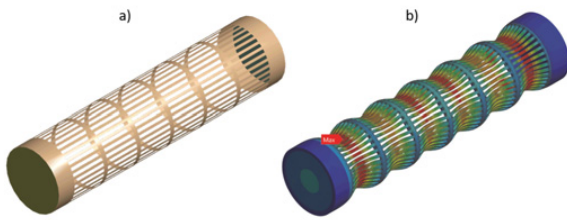
Figure 6. (a) Design of the decay chamber and vacuum window support structure. (b) Simulated with ANSYS software [36] deformation caused by overpressure of 1.3 bar. Red marked area is maximally deformed by 0.32mm. For better visibility, the transverse deformations were exaggerated in the plot.